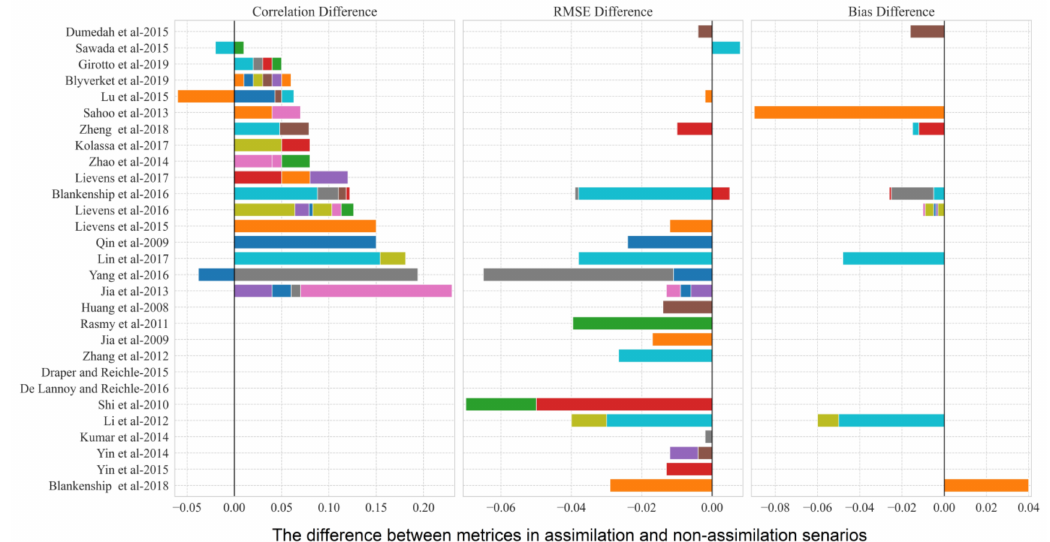
Figure 11. The difference between metrics in assimilation and non-assimilation scenarios for SSM in terms of correlation, bias, and RMSE; the y axis shows the authors of papers, and the three columns show the metrics.